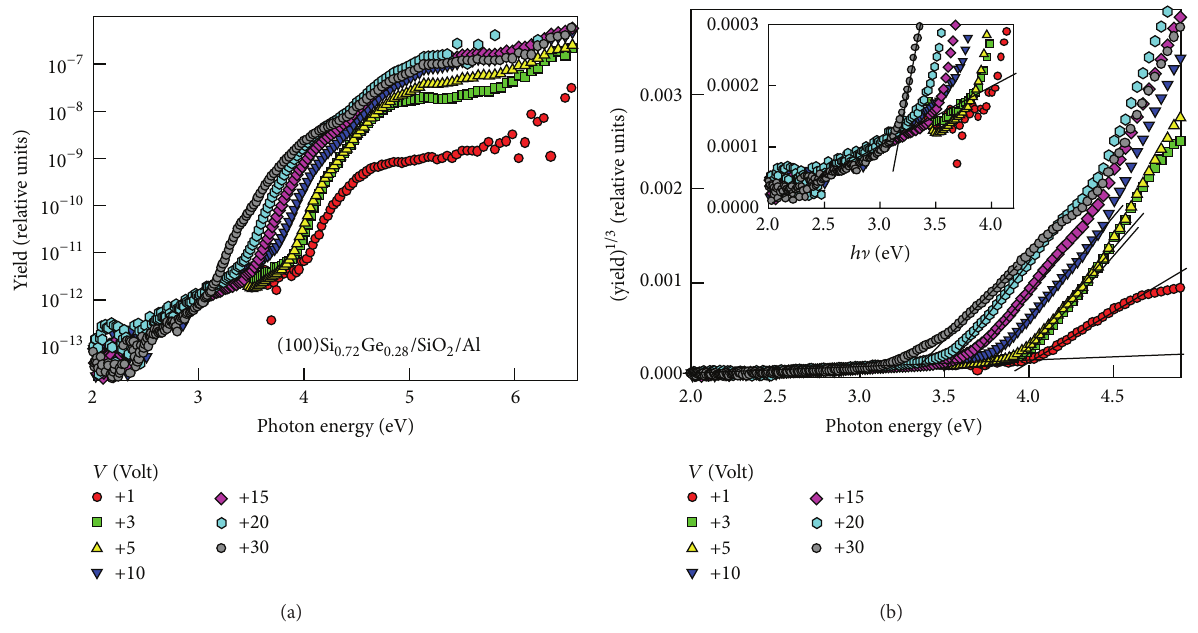
Figure 19: (a) Electron IPE quantum yield as a function of photon energy measured on (100)Si 0.72 Ge 0.28 /SiO 2 (83nm)/Al samples under indicated positive bias on the Al gate electrode. (b) Determination of the electron IPE threshold Φ (Si 1−𝑥 Ge 𝑥 ) using 𝑌 1/3 - ℎ ] plots. Lines guide the eye. The inset shows a magnified view of the photocurrent yield in the subthreshold spectral